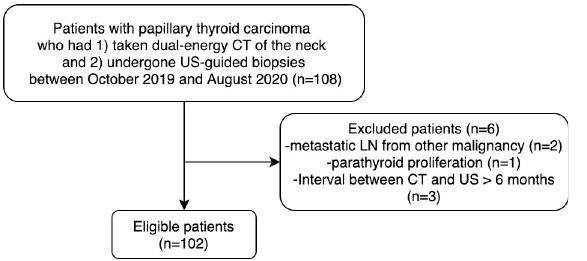
Fig 1. Flow chart illustrating patient selection